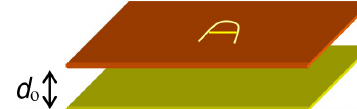
Figure 8. Schematic of a general capacitive sensor.